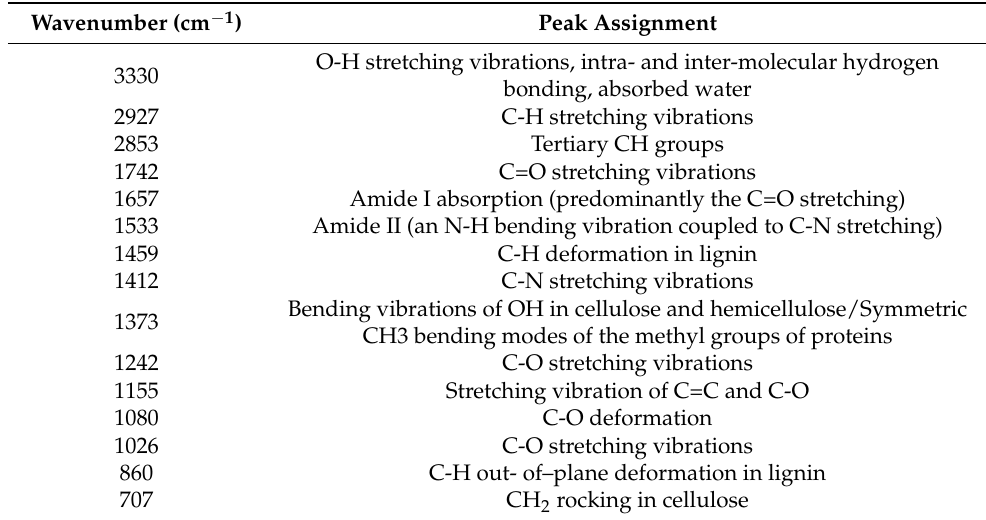
Table A1. Peak assignments of oats in different